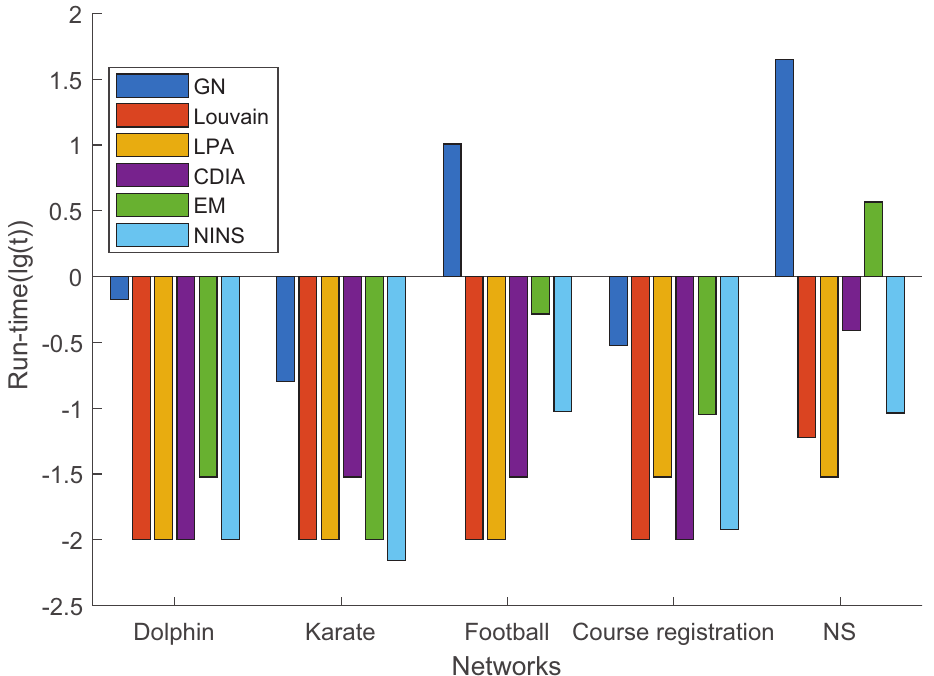
Figure 7. The run-time of NINS and five different algorithms in five real networks.